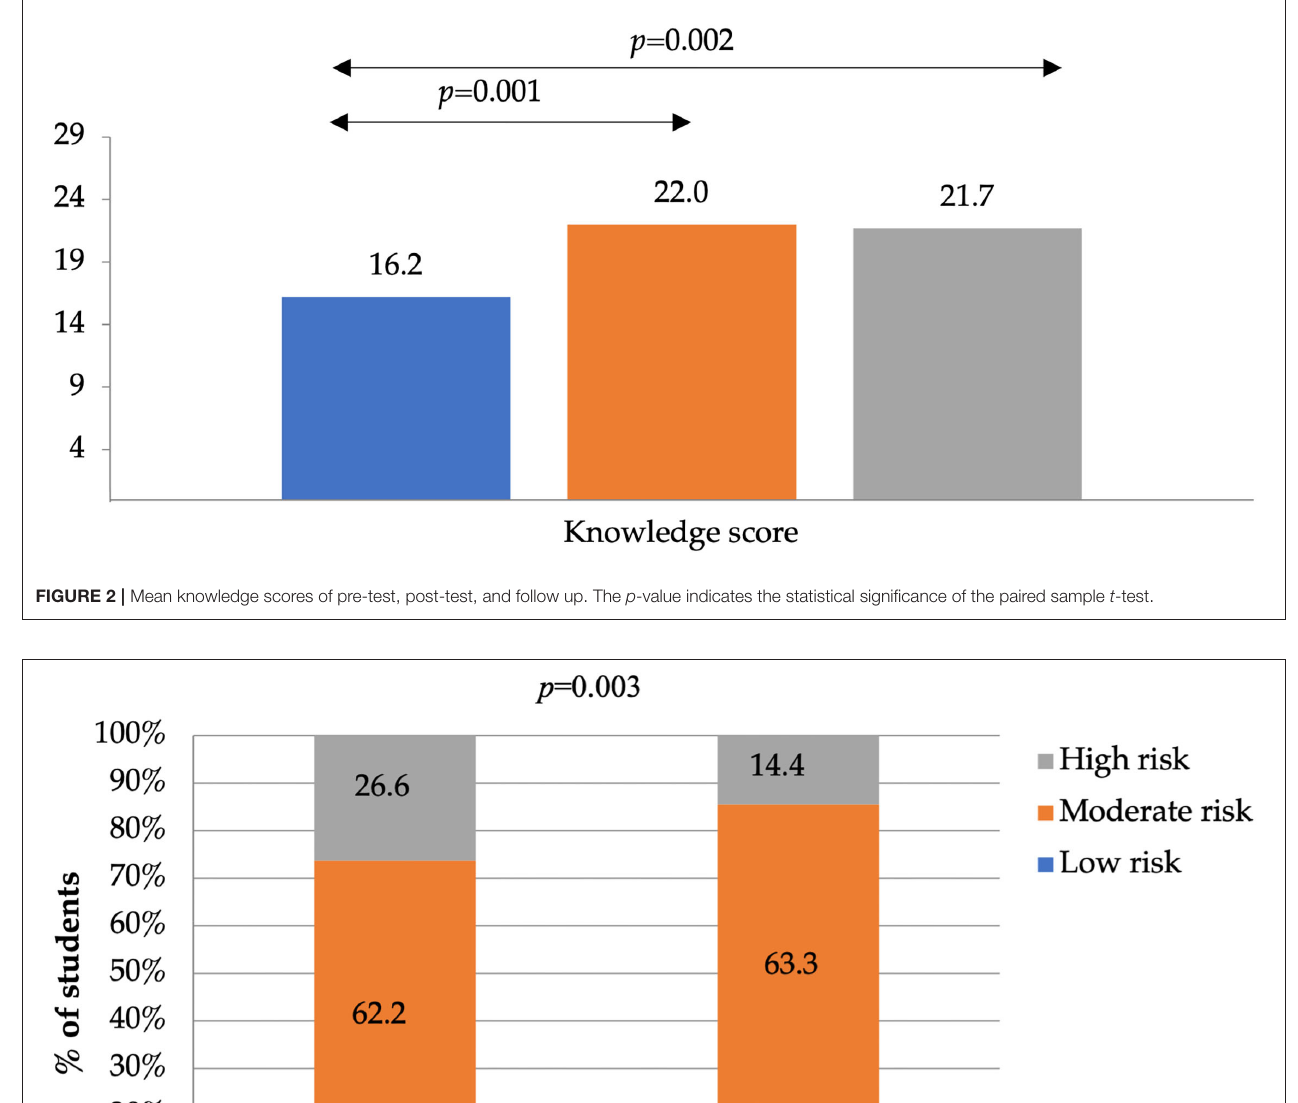
worryingly, a very small proportion of students check for salt content on the food label and use it to guide their food choices. In the previous study among UOS students only 17% reported checking food labels and 20% of students used the labels to guide their purchasing decisions (16).